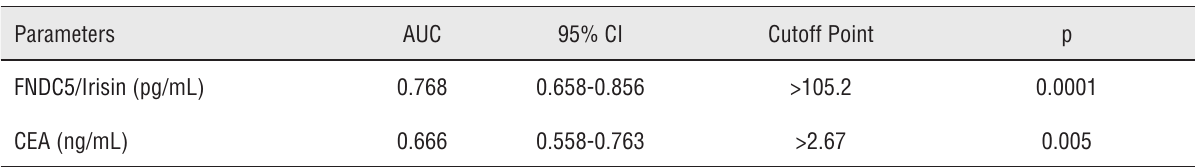
Table 2 - Optimum diagnostic fNDc5/Irisin and cEA cutoff point, AUc according to the receiver operator characteristic (ROc)